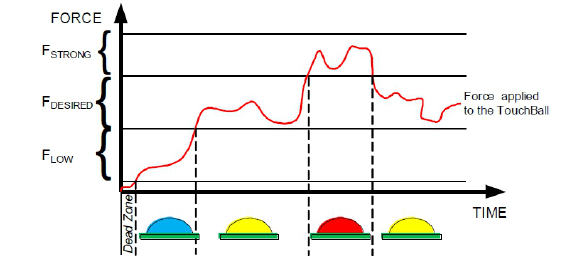
Table 2. Relationships between user’s force and the figure/colour on the Touch Ball.